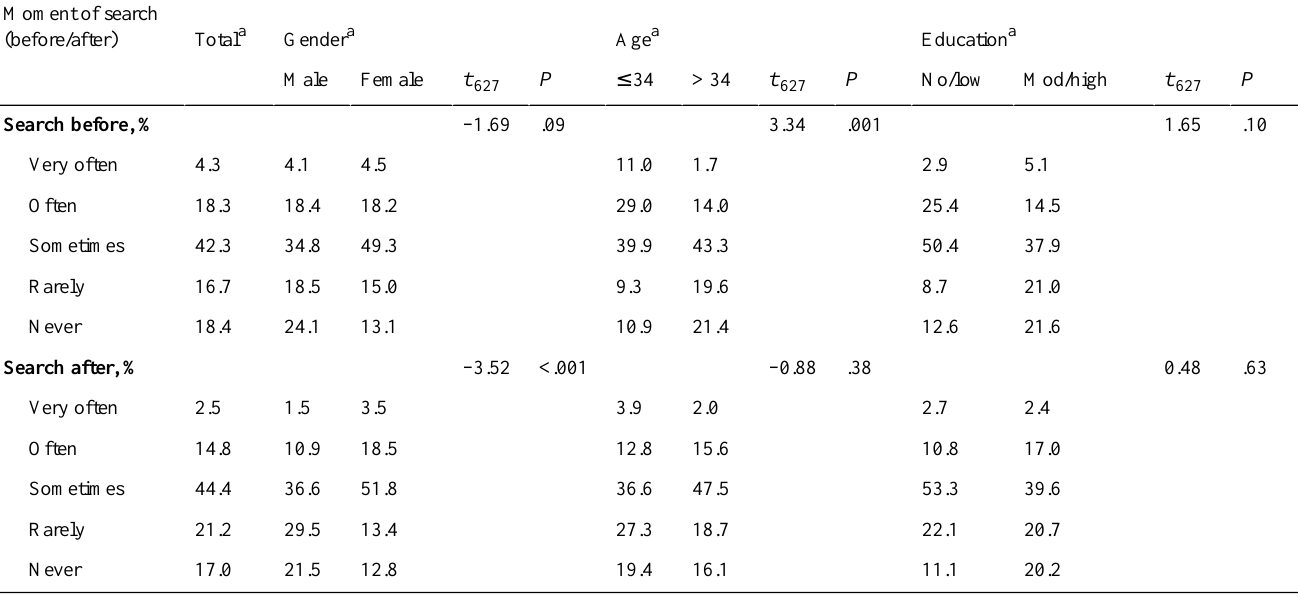
Table 4. Online searches for health-related information before and after visiting physician (general practitioner or